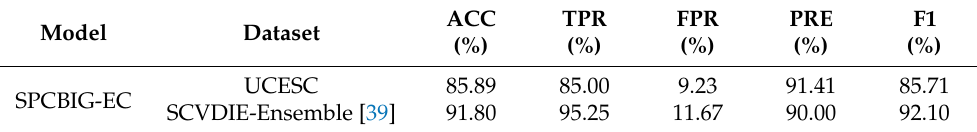
Table 9. Comparison of hybrid vulnerabilities under different datasets.